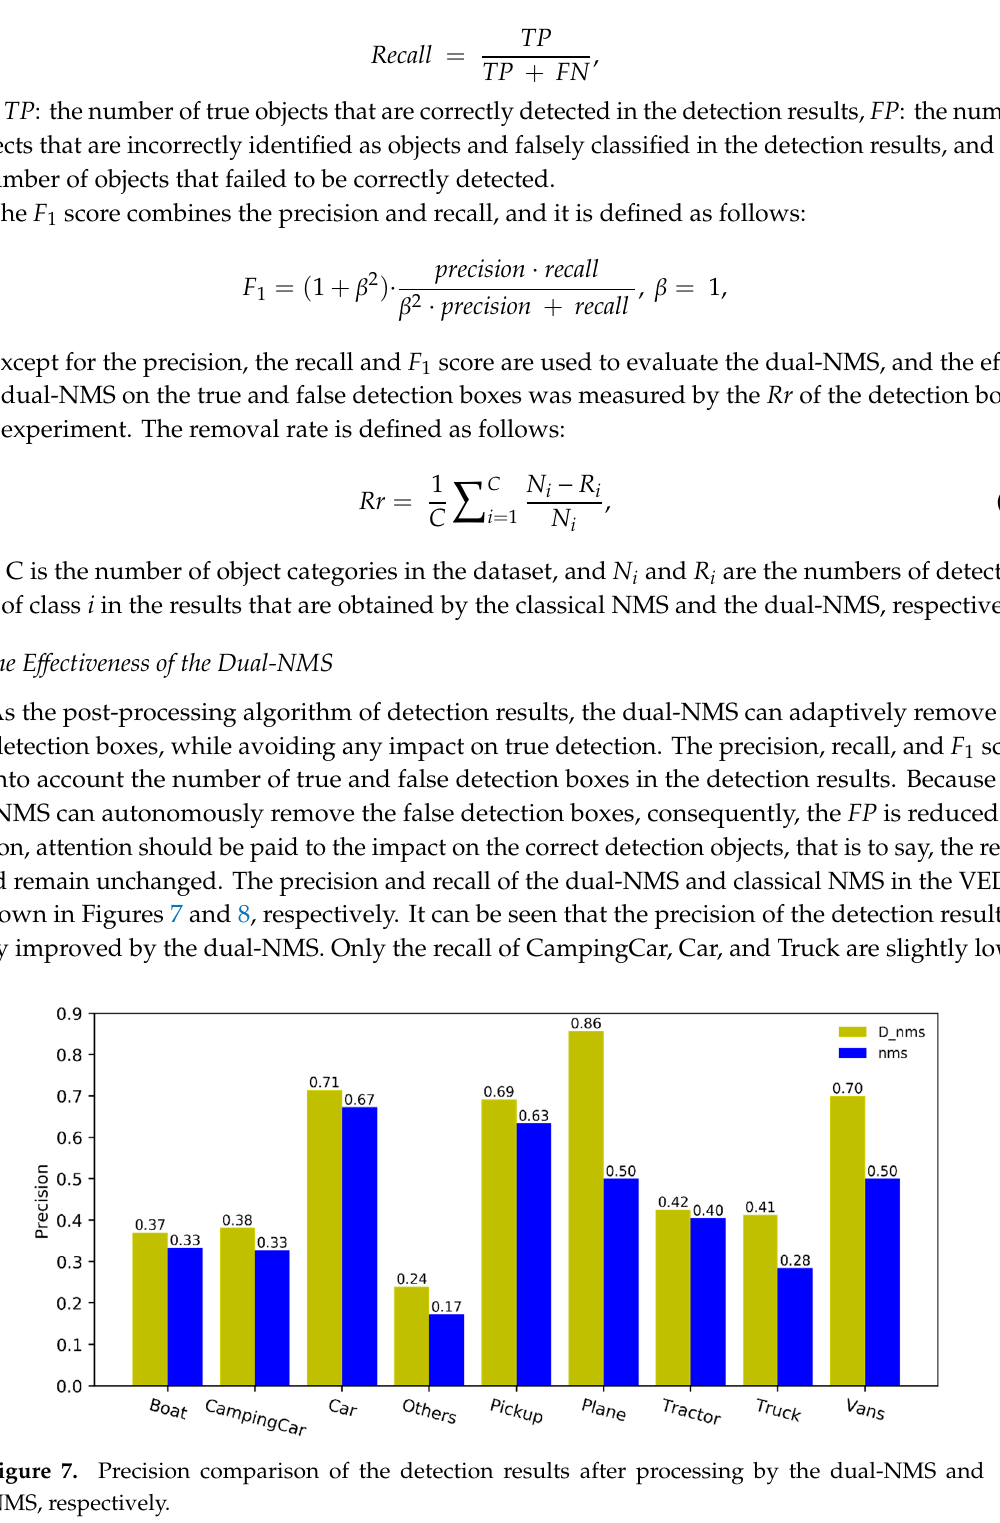
Figure 8. Recall comparison of the detection results after processing by the dual-NMS and NMS, respectively. Table 3. Comparison of the F 1 score for the dual-NMS in different data sets (The best result in each dataset is marked in bold). Model